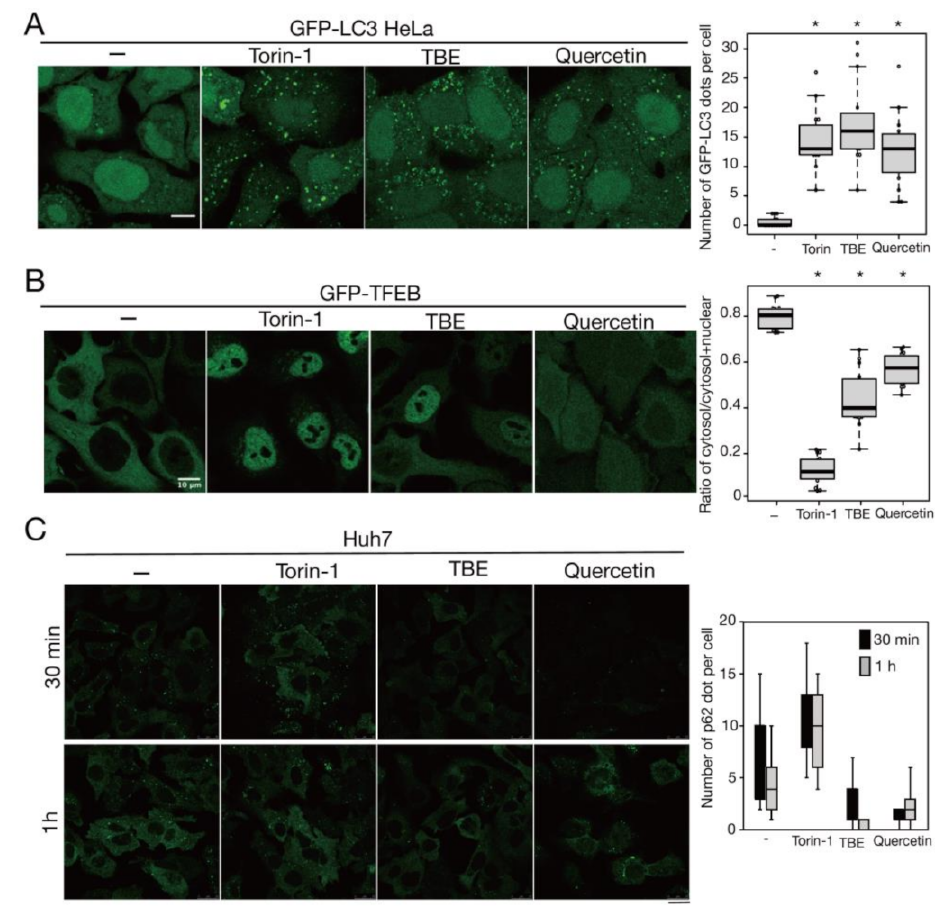
Figure 6. Quercetin enhances autophagy. ( A ) GFP-LC3-expressing HeLa cells were treated with or without Torin-1, TBE, or quercetin for 4 h under nutrient-rich conditions. The graph shows the number of GFP-LC3 punctae over 1.3 µ m in diameter per cell. ( B ) GFP-TFEB-expressing HeLa cells were treated with or without Torin-1, TBE, or quercetin for 4 h under nutrient-rich conditions. The graph shows the ratio of GFP intensity in a certain area of the cytosol to the sum of GFP intensities in certain areas of the cytoplasm and nucleus. ( C ) Huh7 cells were treated with puromycin for 4 h, and further cultured with or without Torin-1, TBE, or quercetin for 1 h after washing out puromycin. Intracellular p62 was detected by immunostaining. The graph shows the number of p62 dots over 2.5 µ m in diameter per cell. Median: line; upper and lower quartiles: boxes; 1.5 interquartile range: whiskers. Bar: 10 µ m for ( A , B ); 25 µ m for ( C ). * denotes p < 0.05 by unpaired two-tailed Student’s t